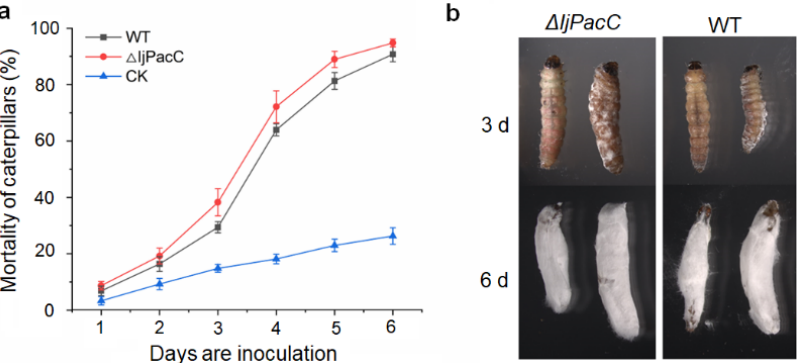
Figure 4. Virulence of the ∆ IjpacC mutant and wild-type strains of I. javanica on the potato tuberworm. ( a ) Mortality curve of caterpillars infected with different I. javanica strains. CK: control, caterpillars were treated with sterile water. ( b ) Fungus parasites on caterpillars after inoculation for 3 and 6 days. Error bar represents the standard error of the mean.